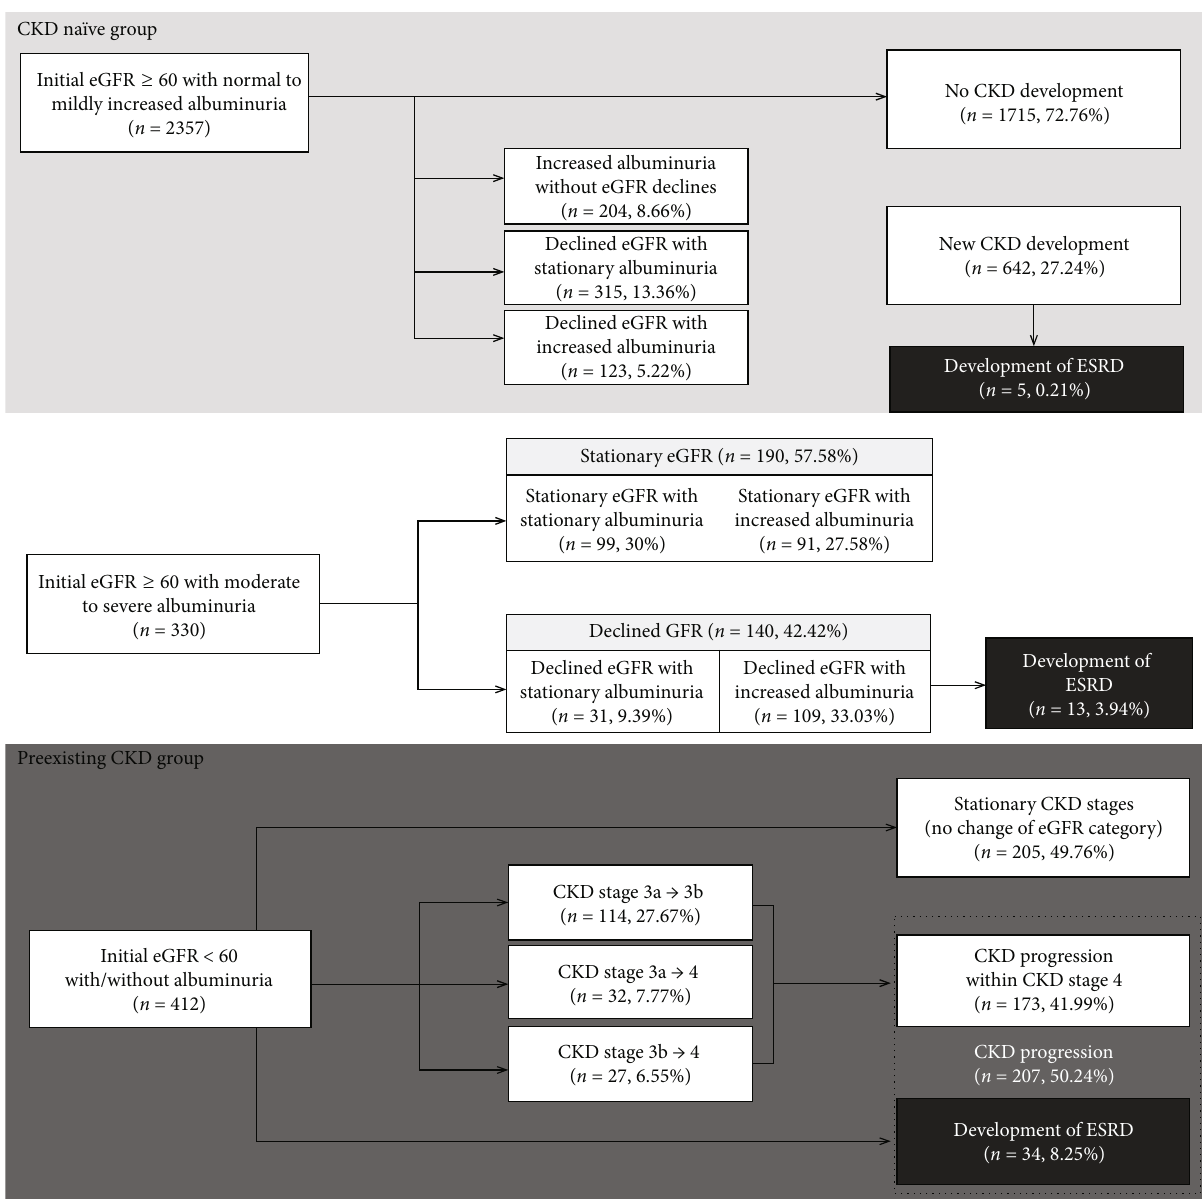
Figure 1: Development of chronic kidney disease (CKD) in the CKD-naïve group and CKD progression in the preexisting CKD group after 10 years. Abbreviations: CKD: chronic kidney disease; ESRD: end-stage renal disease; eGFR: estimated glomerular fi ltration